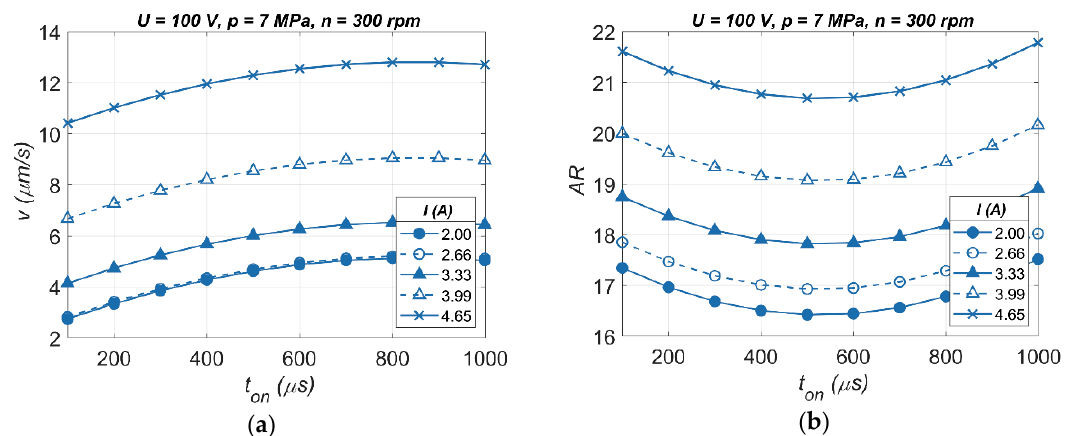
Figure 16. The impact of various values of the current amplitude on: ( a ) the drilling speed v ; ( b ) the hole’s aspect ratio AR .